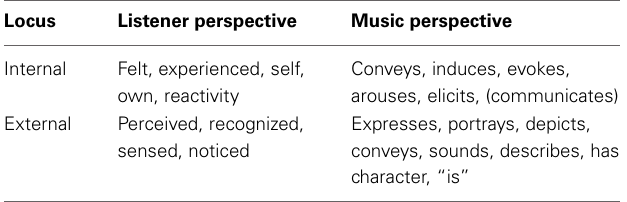
Table 1 | Terminology of emotion locus levels by grammatical subject